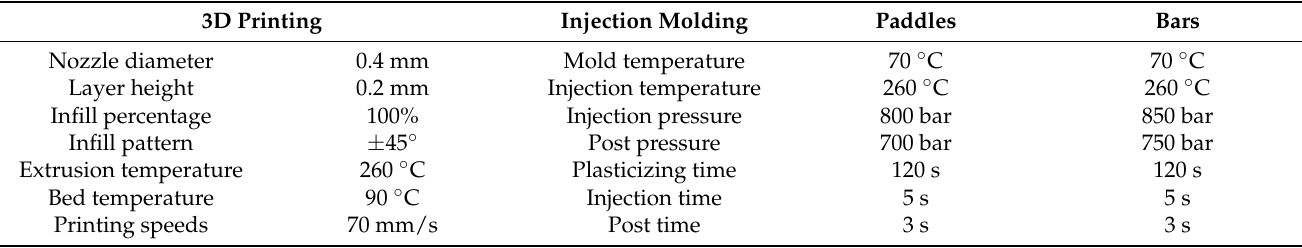
Table 2. Three-dimensional printing and injection molding